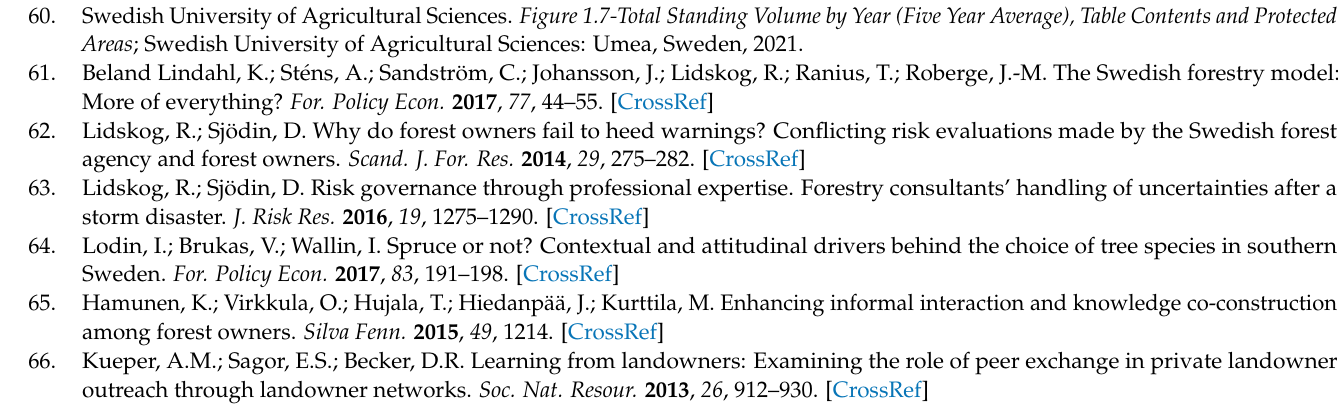
Swedish University of Agricultural Sciences. Figure 1.7-Total Standing Volume by Year (Five Year Average), Table Contents and Protected Areas ; Swedish University of Agricultural Sciences: Umea, Sweden,